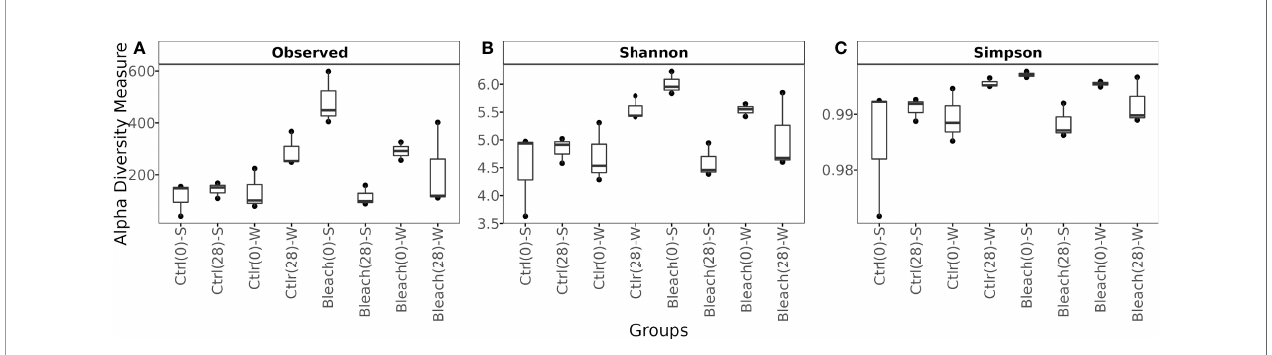
FIGURE 3 | Box plot showing observed ASVs and Alpha diversity metrics. (A) Number of observed ASVs, (B) Shannon (H ’ ), and (C) Simpson diversity indexes of the bacterial community in mucus samples from control (Ctrl) and bleached (Bleach) medusas in summer (S) and winter (W). Values are from 3 samples per symbiotic condition and season (at the start (0) and end (28) of 28 days of manipulations). See Supplementary Material 4 for raw